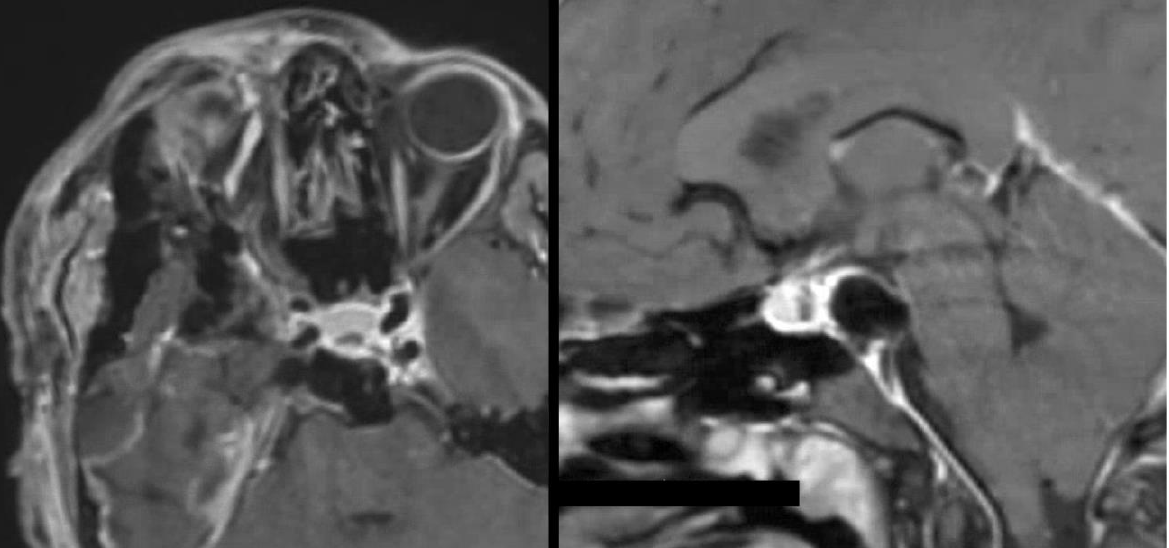
Figure 4. Intraoperative T1-weighted MRI with contrast and fat saturation showing gross total resection of the upper clival chondrosarcoma.